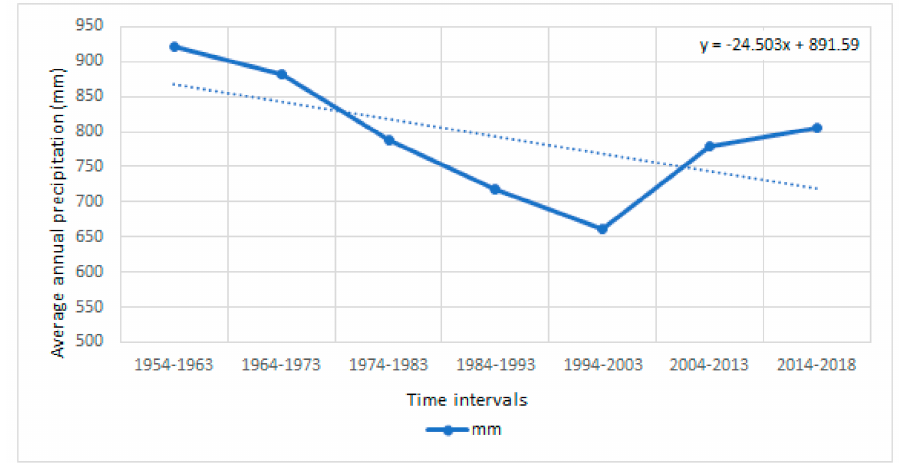
Figure 12. Average annual precipitation over 10-year periods. The average annual precipitation decreases constantly from 921.82 mm/year to 661.56 mm/year (28%) in the period 1954–2003, while a slight increase is recorded in the period 2004–2014.